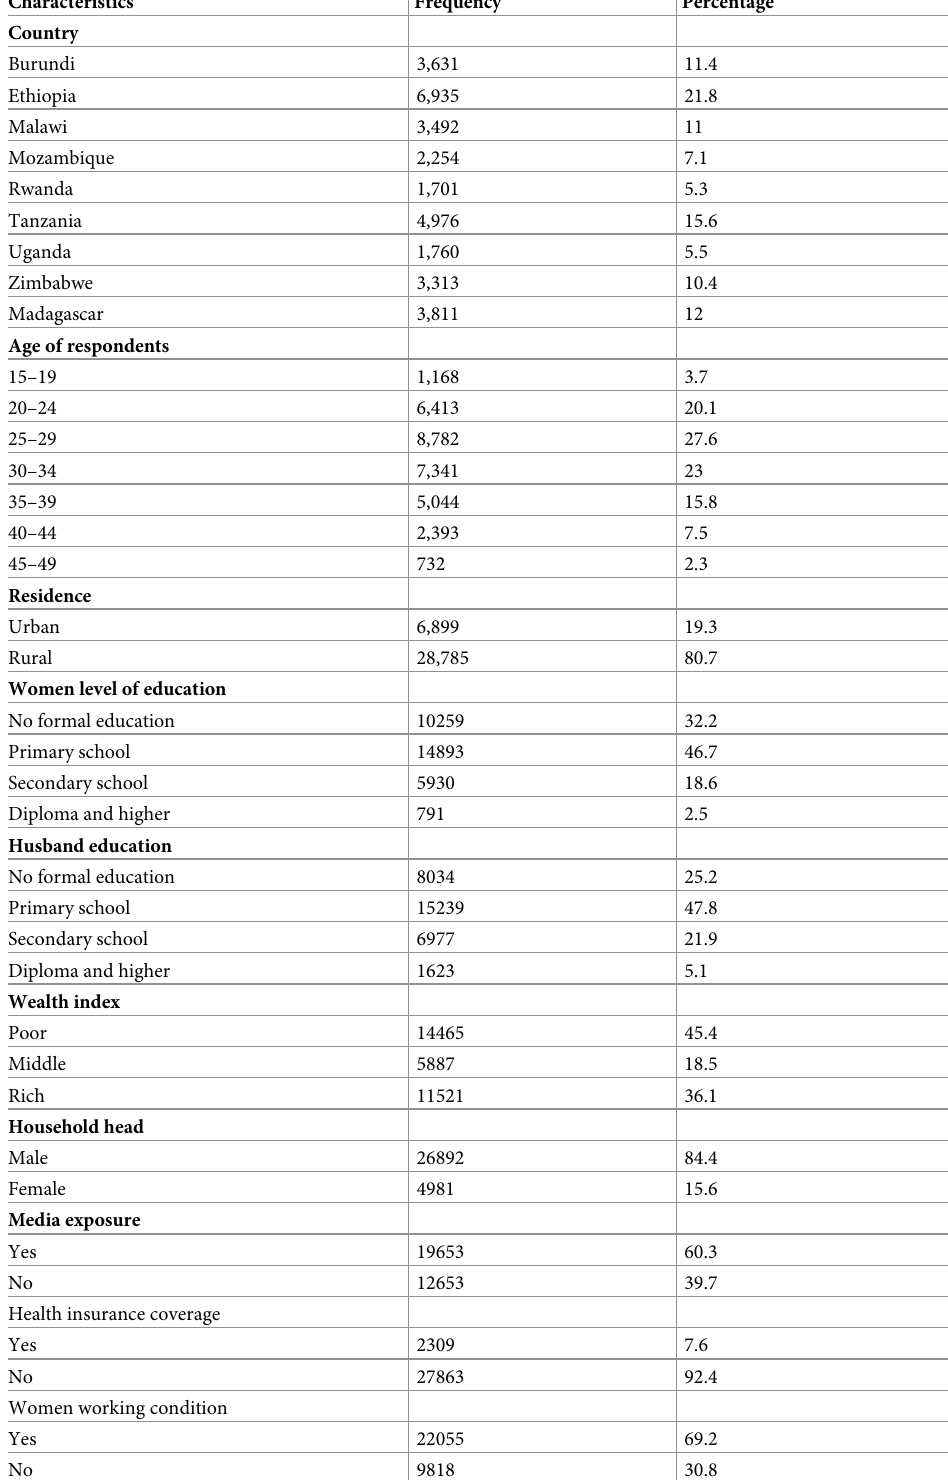
Table 1. Socio-demographic characteristics of reproductive age women in east Africa